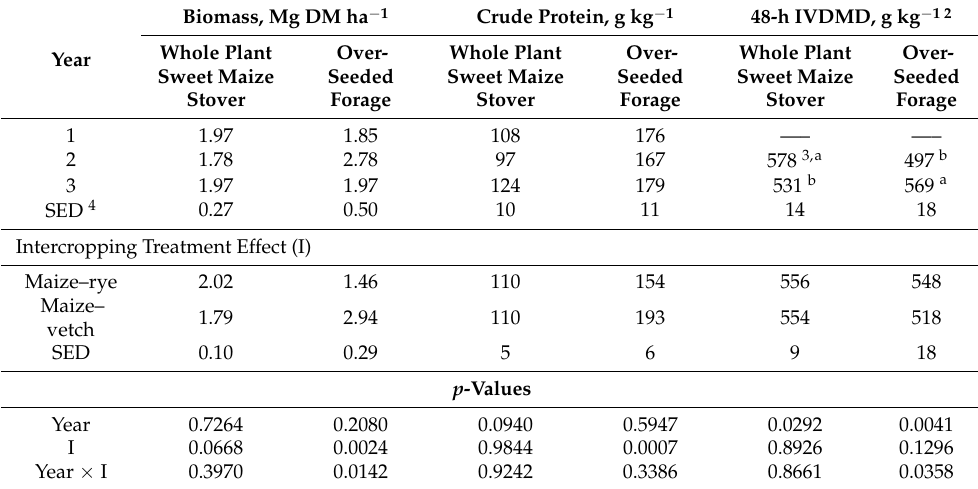
Table 2. Relay intercropping treatment main effect means of pre-grazing (mid-April) biomass dry matter (DM) yield, crude protein concentration, and 48-h in vitro dry matter disappearance (48-h IVDMD) of sweet maize stover intercropped with rye or hairy vetch and the overseeded forage species over three years at Alcalde, NM, USA 1 . Biomass, Mg DM ha − 1 Crude Protein, g kg − 1 48-h IVDMD, g kg − 12 Whole Plant Over- Whole Plant Over- Whole Plant Over- Year Sweet Maize Seeded Sweet Maize Seeded Sweet Maize Seeded Stover Forage Stover Forage Stover Forage 1 1.97 108 176